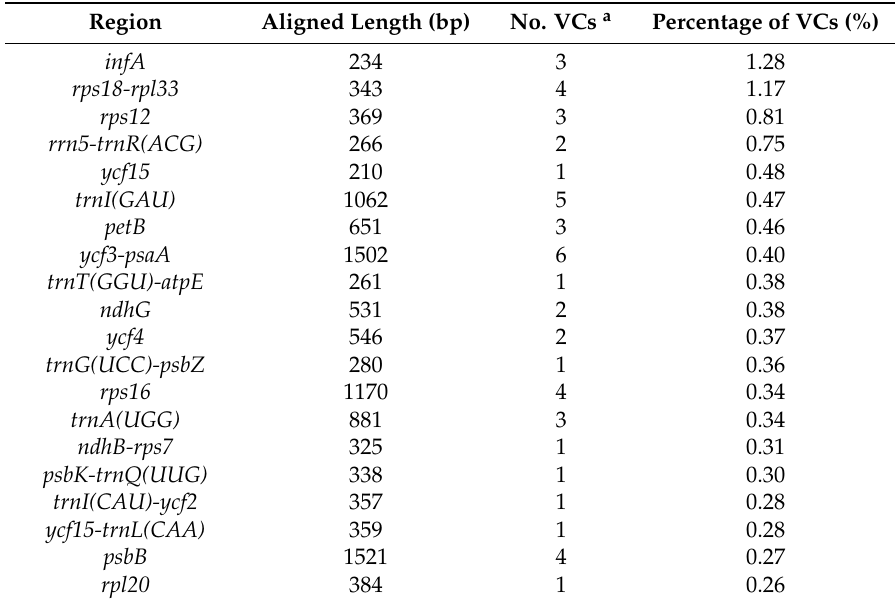
Table 3. The 20 chloroplast DNA fragments with relative high genetic divergences identified in Eucommia ulmoides .